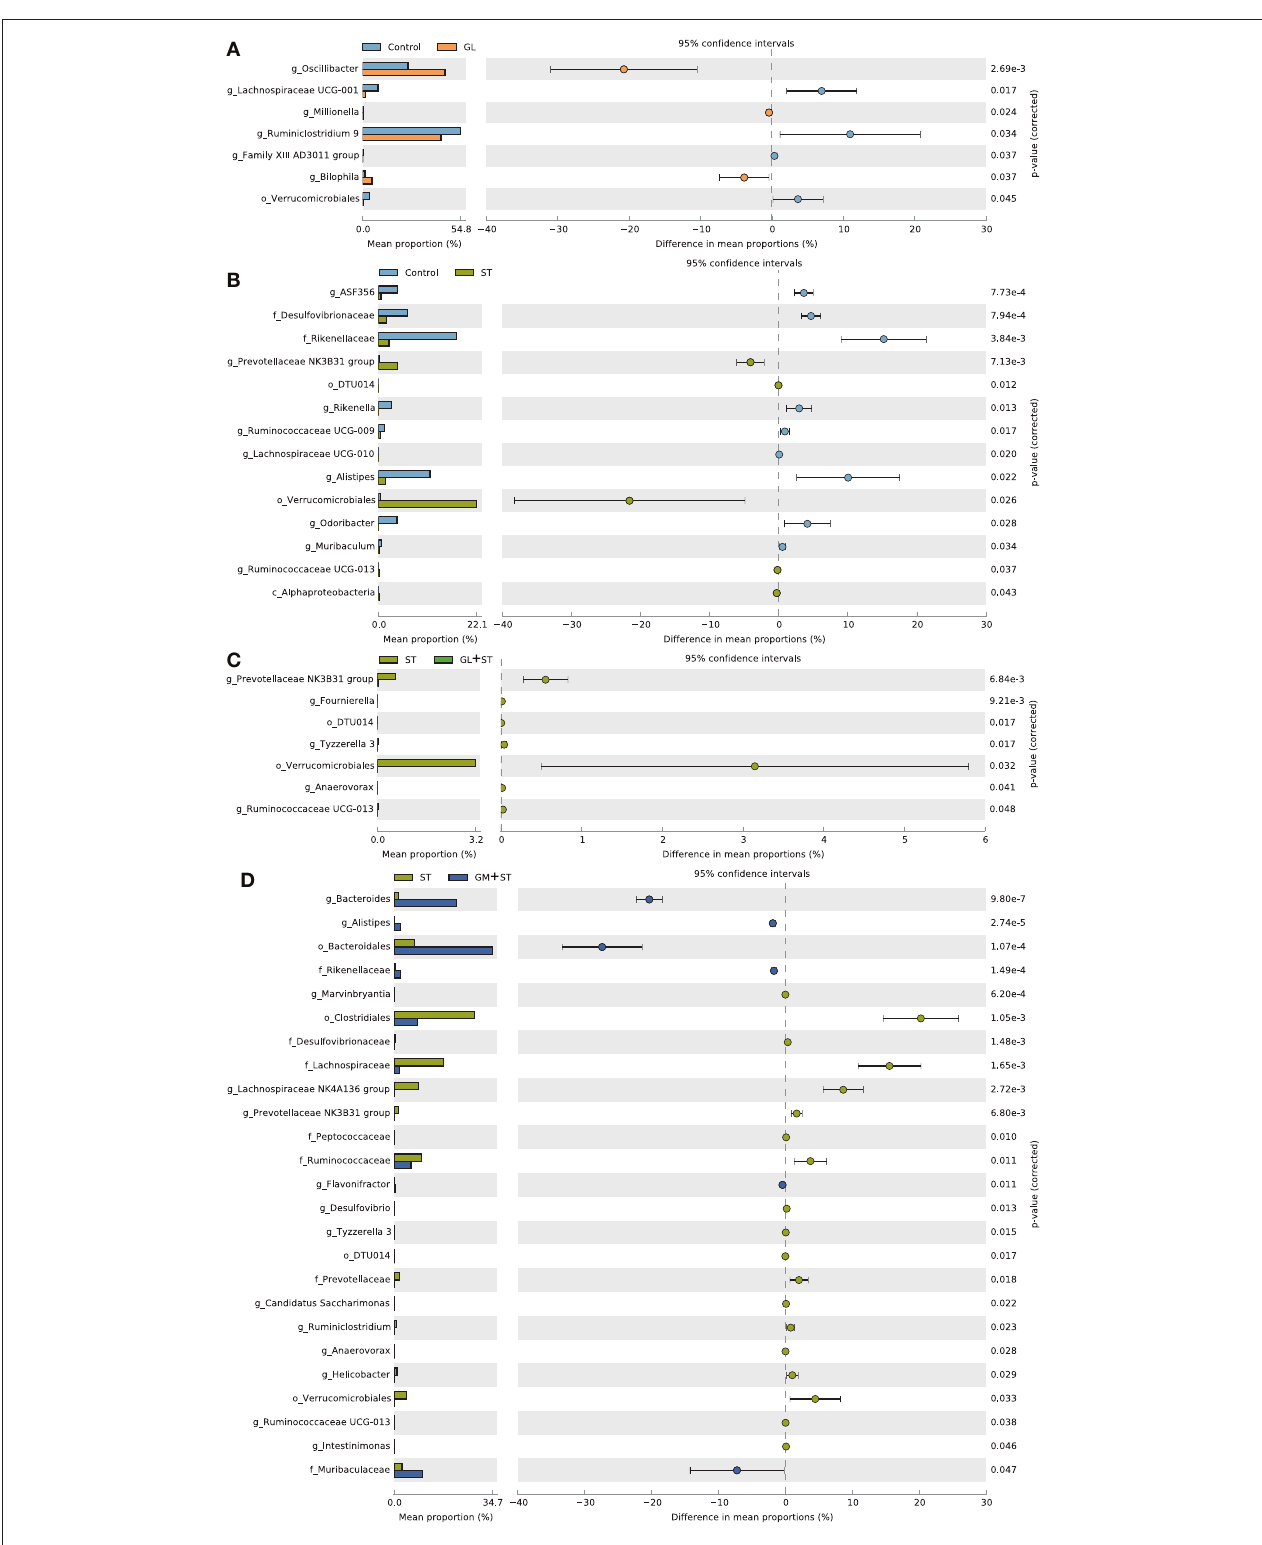
FIGURE 8 | Comparison of the intestinal bacteria among different treatments. (A) Control vs. GL, (B) Control vs. ST, (C) ST vs. GL + ST, (D) Control vs. GM + ST. Confidence Interval was set at 95%.